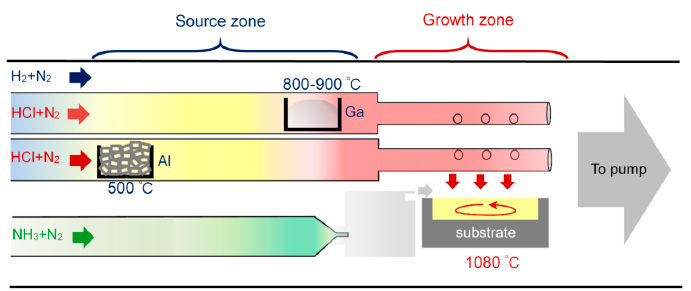
Figure 1. Schematic diagram of the hydride vapor phase epitaxy (HVPE) reactor used for the AlGaN growth.